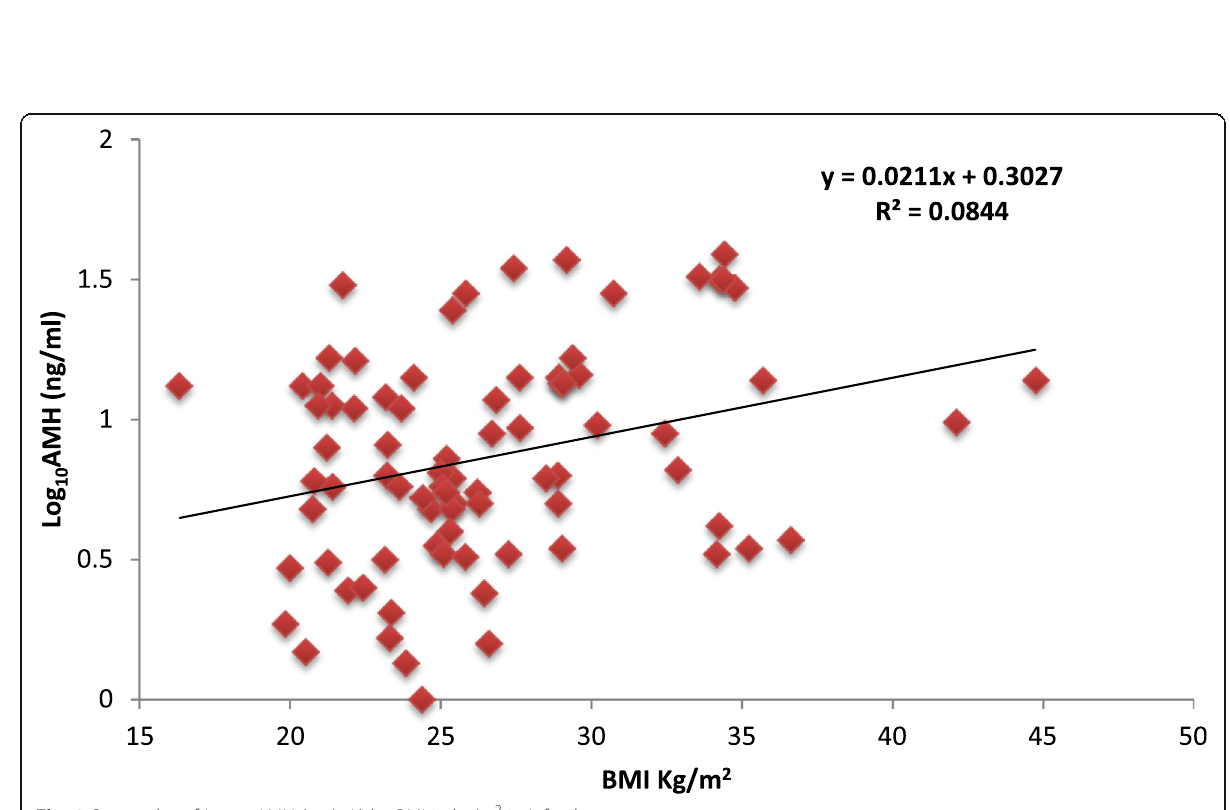
Fig. 3 Scatterplot of Log 10 AMH (ng/mL) by BMI in kg/m 2 in Infertile